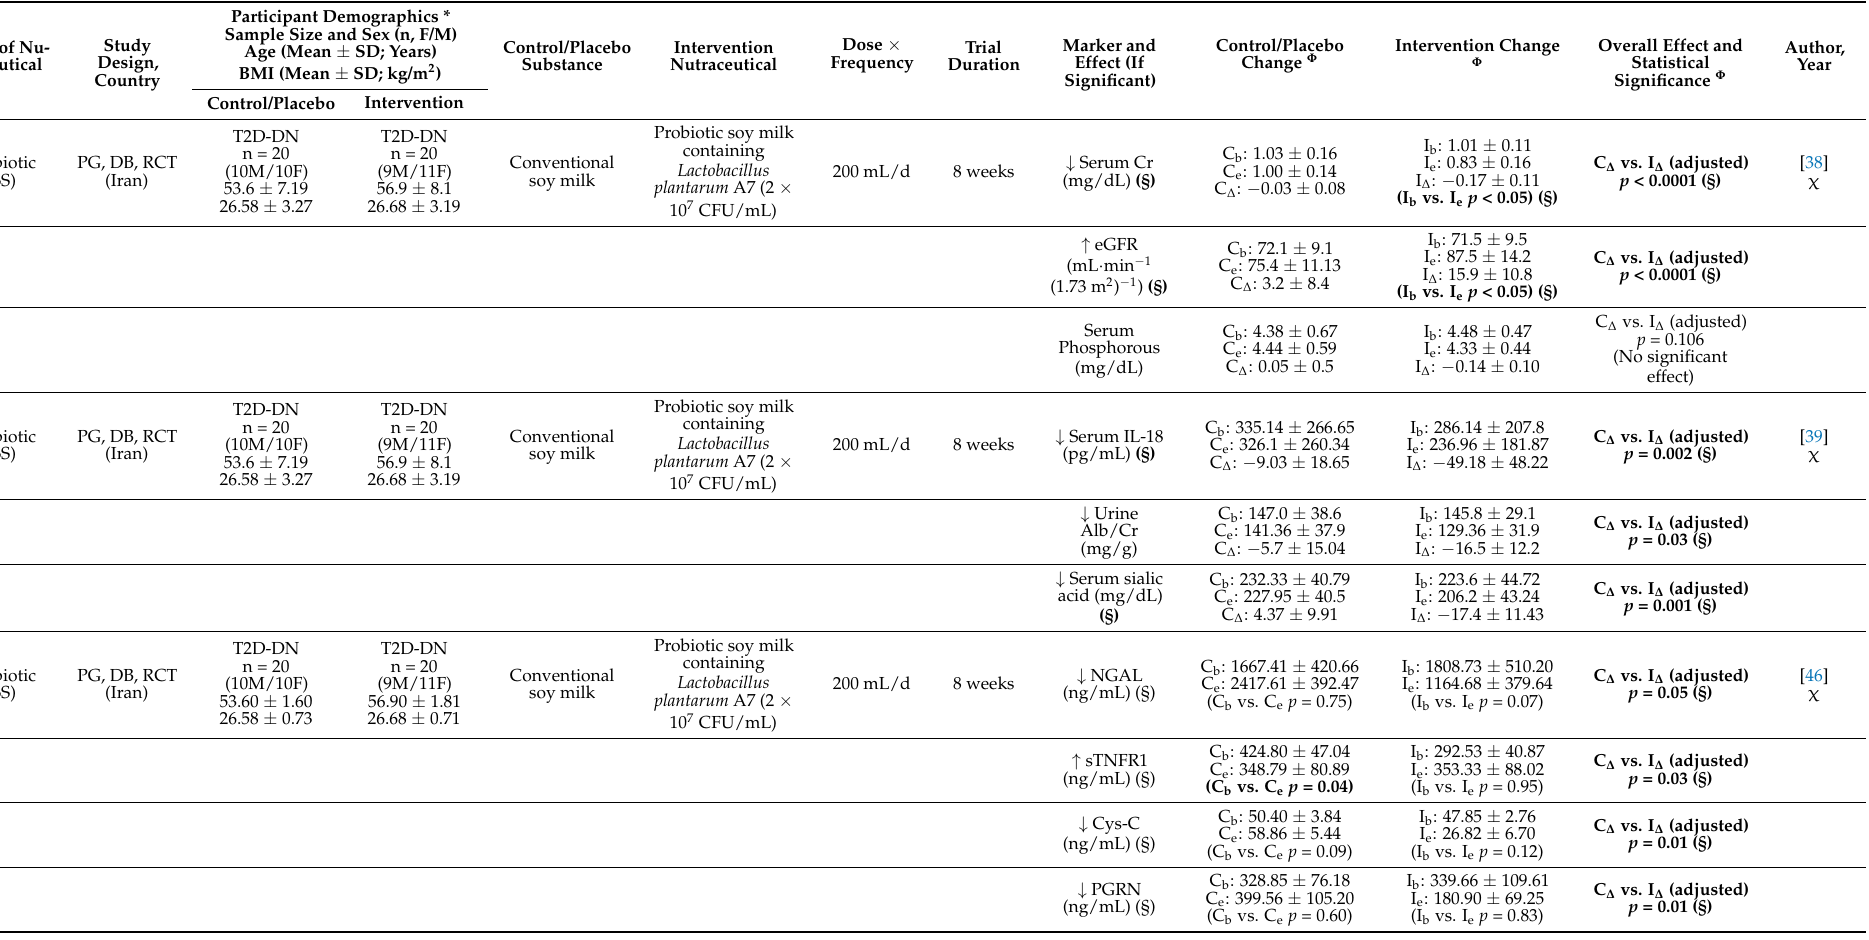
Table 1. Studies investigating changes in renal biomarkers following intervention with probiotics, prebiotics, and synbiotics, sorted according to nutraceutical